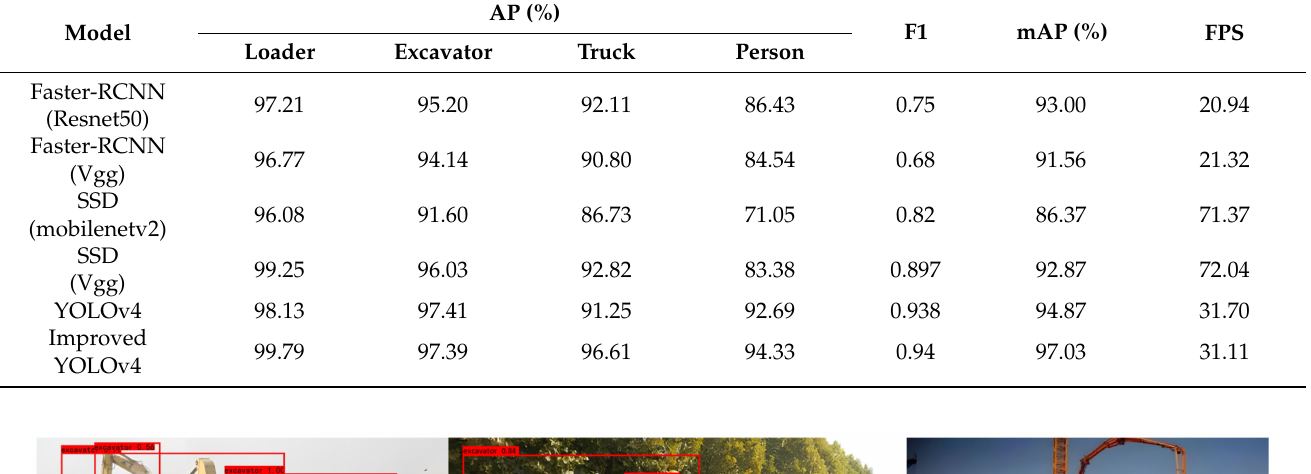
Table 3. Performance comparison of different models.